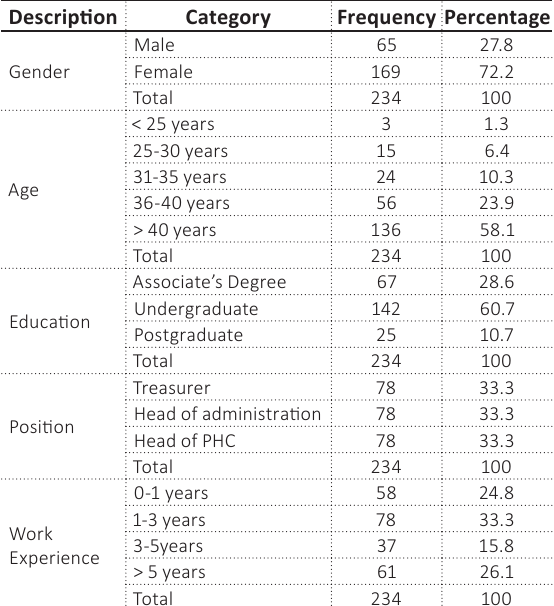
Table 3. Demographic profile of respondents